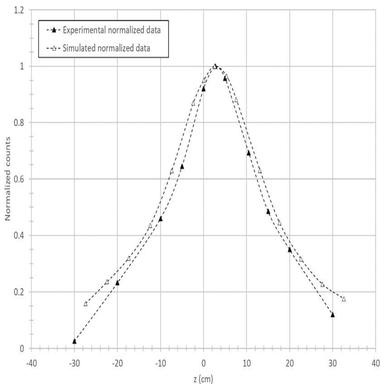
Comparison of the vertical scanning of the drum obtained using the MCNP6 model with the experimental data acquired at the SAPHIR platform.